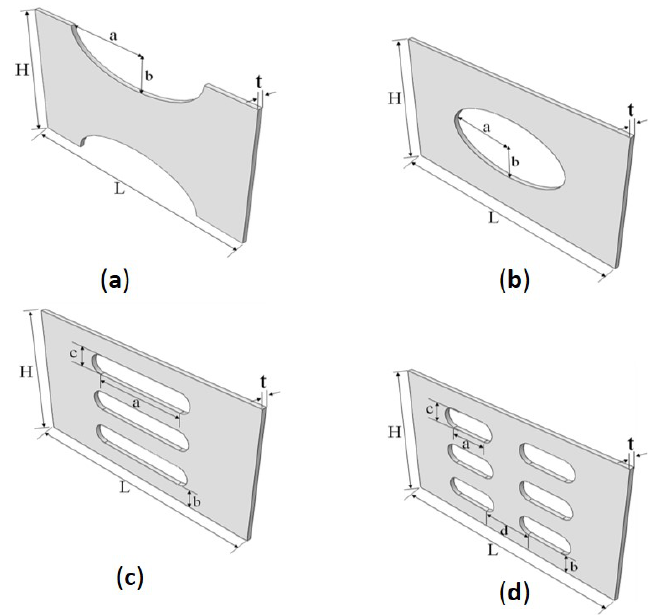
Figure 1. Section dimensions of the components: ( a ) Plate with split elliptic pores (SP1); ( b ) Plate with one central elliptic pore (SP2); ( c ) Plate with single column of uniform pores (SP3); ( d ) Plate with two columns of uniform pores (SP4).